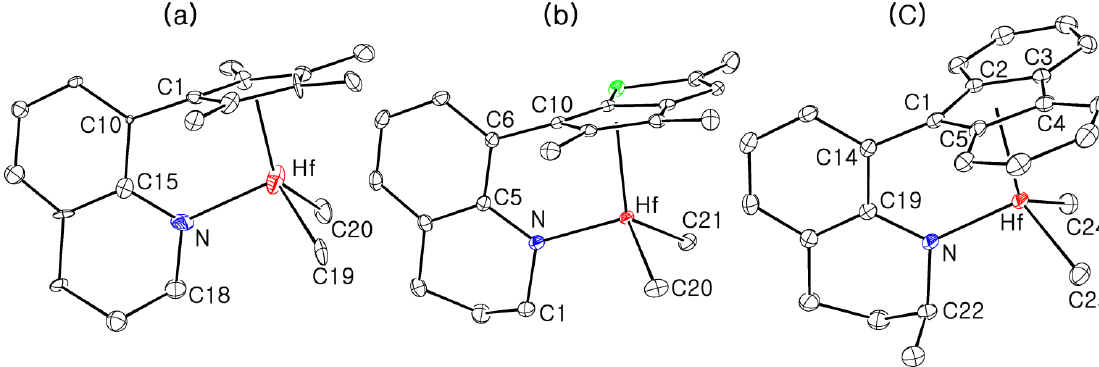
Figure 2. Thermal ellipsoid plot (30% probability level) of 1 ( a ), 3 ( b ), and 6 ( c ). Hydrogen atoms are omitted for clarity. Selected bond distances (Å) and angles (°) in 1 ( a ): Hf-N, 2.15(2): Hf-C(19), 2.20(2);